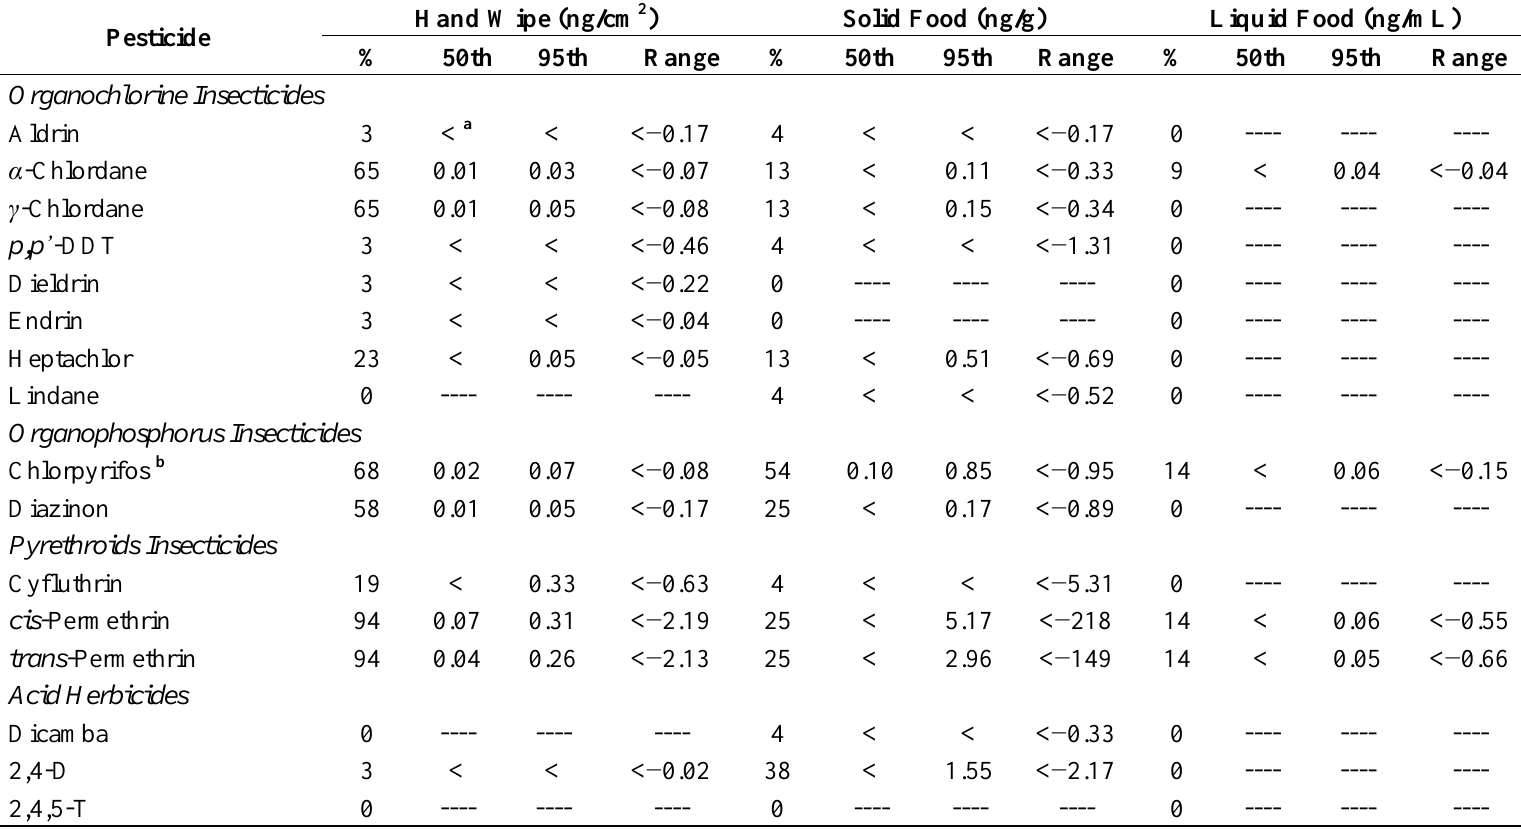
Table 6. Concentrations of pesticides in personal exposure samples collected from 63 children at their daycare centers in North